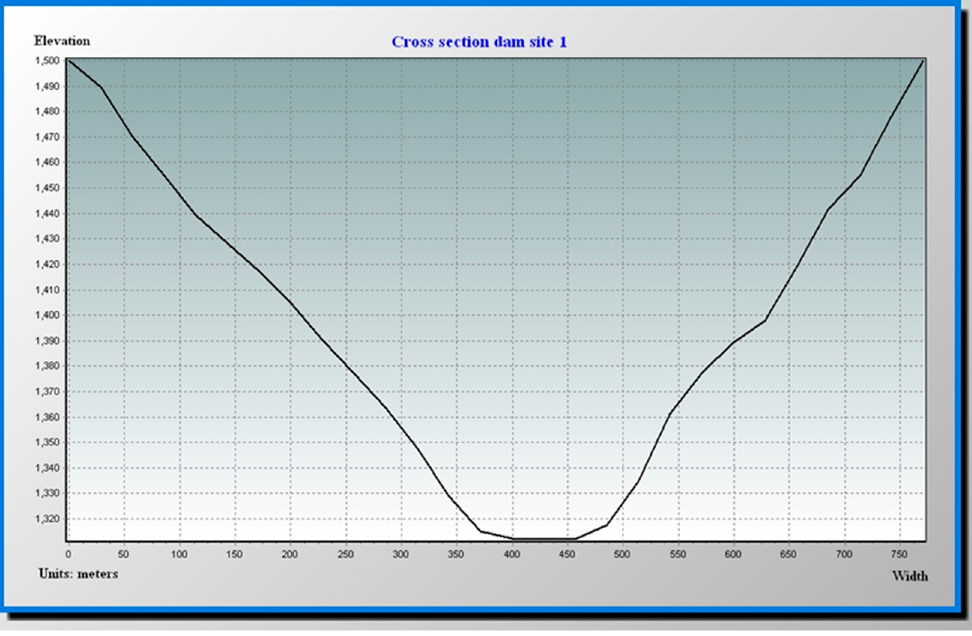
Figure 13. Cross-section area of Dam site 1.